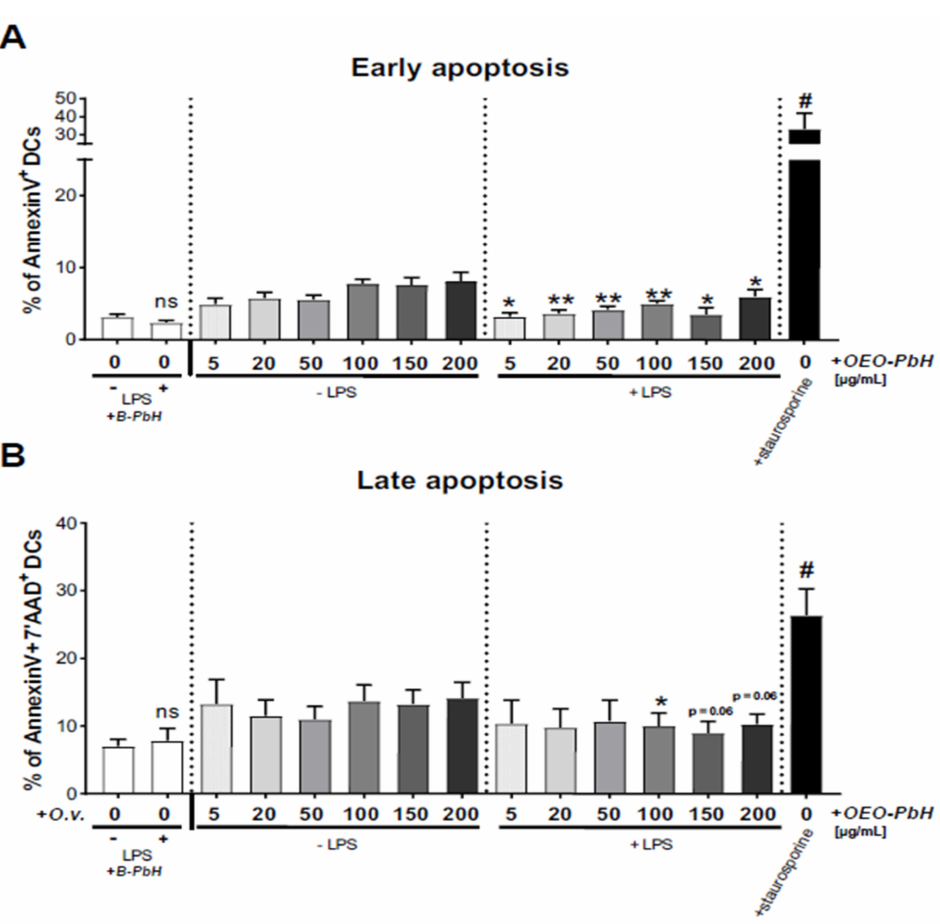
Figure 10. Effects of OEO-PbH on the apoptosis of human DCs. DCs were cultured for 7 days with GM-CSF and IL-4. Cells were subsequently stimulated without LPS or with LPS and treated with OEO-PbH at different concentrations for 24 h. The frequency of early (AnnexinV + ) apoptotic DCs ( A ) as well as late (AnnexinV + /7 (cid:48) AAD + ) apoptotic DCs ( B ). Staurosporine-treated DCs were used as a positive control (black bar). Data expressed as mean ± SEM ( n = 6 donors); # indicates com- parisons to the blank control (B-PbH-treated DCs) using RM one-way ANOVA; * indicates group comparisons between LPS-treated and LPS-untreated cells using paired t -test (* p < 0.05; ** p < 0.01; ns = not